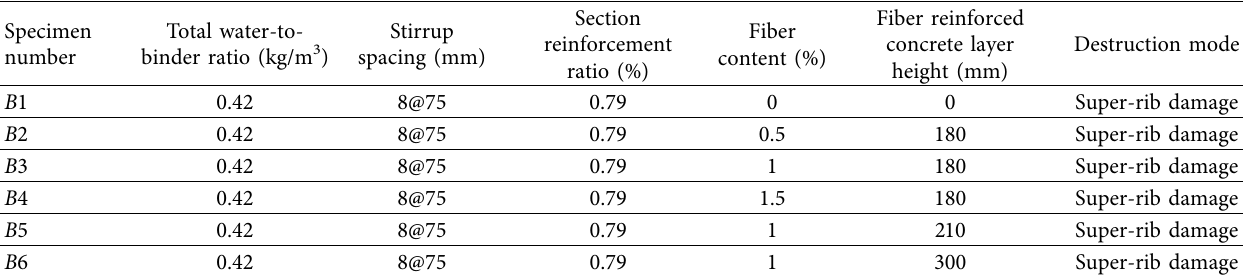
Table 1: Specimen parameters.